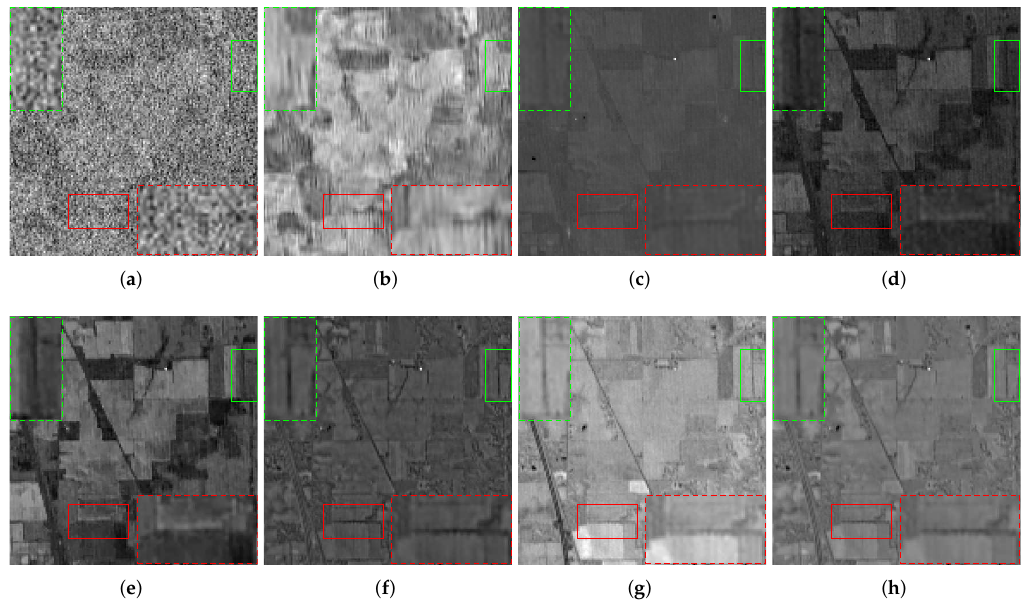
Figure 11. Restored results of band 107 by different algorithms in Indian Pines dataset. ( a ) The observed;